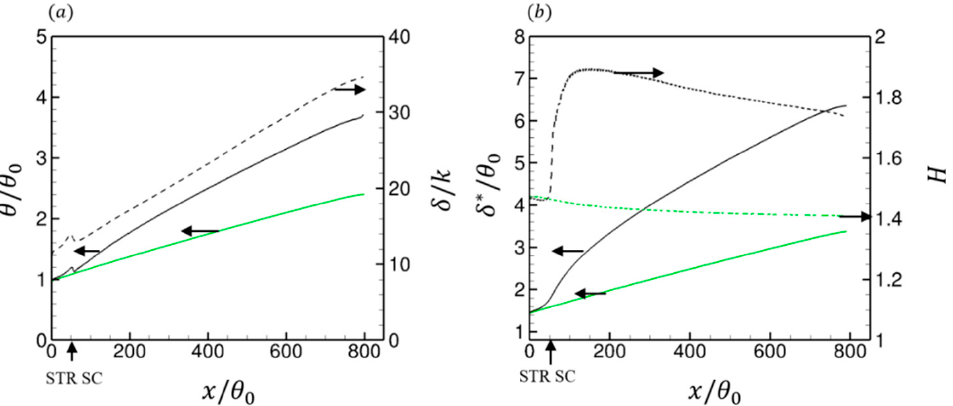
Figure 10. Streamwise evolution of momentum thickness ( a ), displacement thickness (left axis of ( b )), and shape factor (right axis of ( b )) for the two cases: 𝑆 (green) and 𝑅 (black). In addition, included in ( a ) is the variation of 𝛿/𝑘 ratio for the rough-wall case (dashed line). The horizontal arrows indicate the 𝑦 -axis to which each line points to. The vertical arrows on the 𝑥 –axes indicate the location of the STR step change.